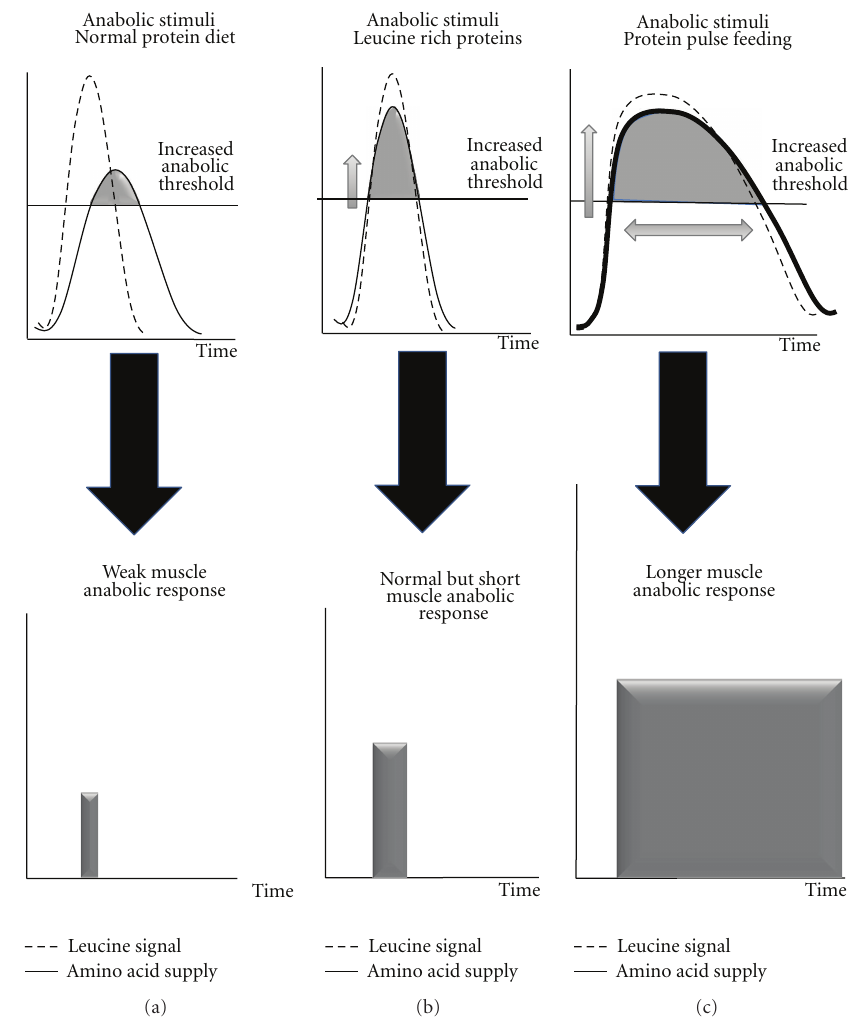
Figure 2: Free leucine, leucine rich proteins, and high protein diet in terms of amino acid kinetic and associated anabolic response in situation of increased muscle anabolic